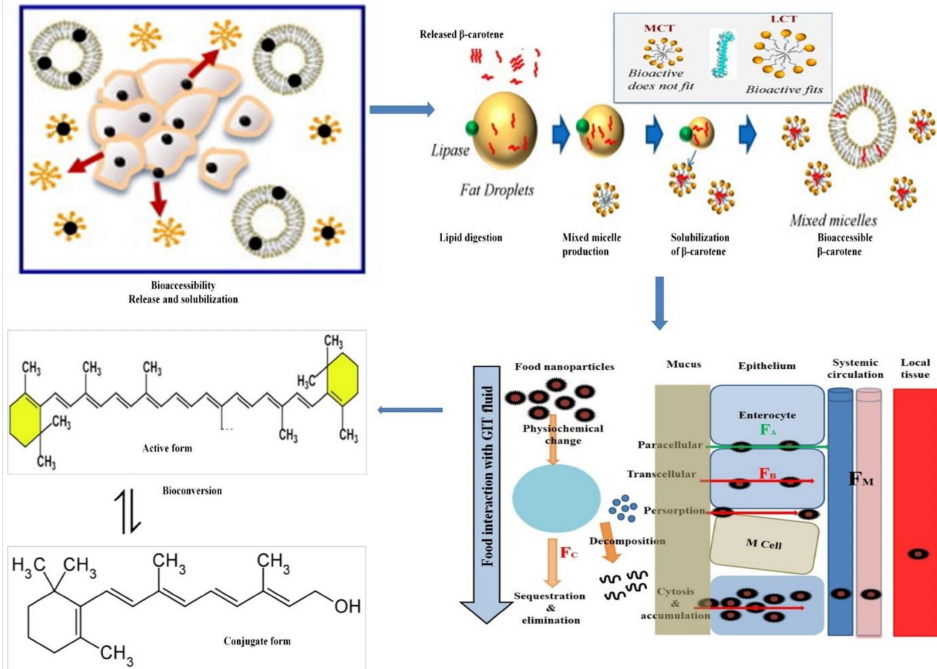
Figure 4. Factors influencing the bioavailability of β -carotene during absorption in the gastrointestinal tract (GIT). Paracel- luar absorption, M-cell uptake via Peyer’s patches and Chylomicron-assisted enterocyte